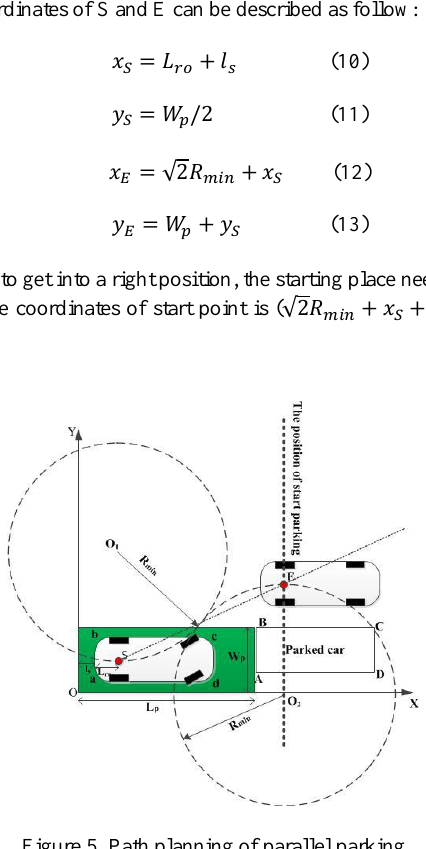
Figure 5. Path planning of parallel parking algorithm. The white points stand for the accessible path, and the yellow points represent the start point and parking